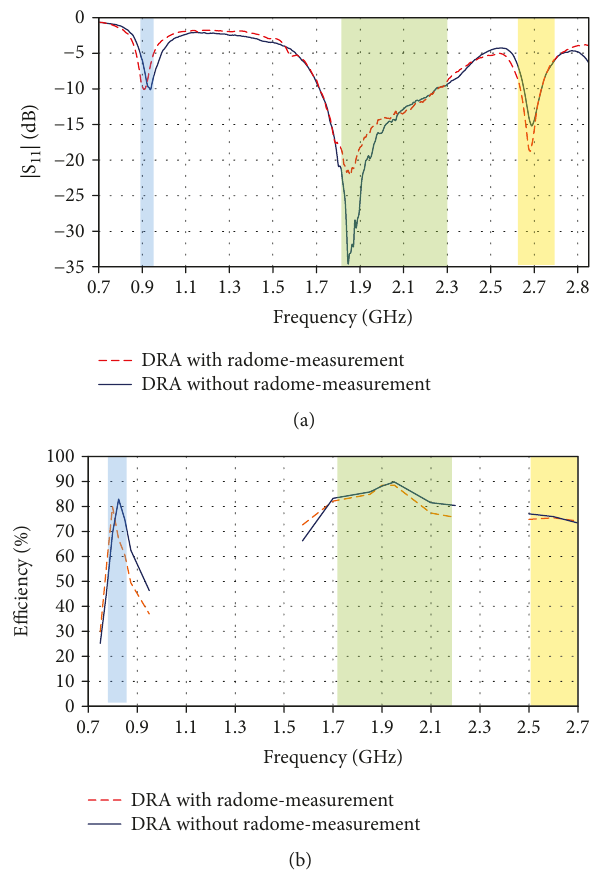
∣ parameter (a) and on the 11